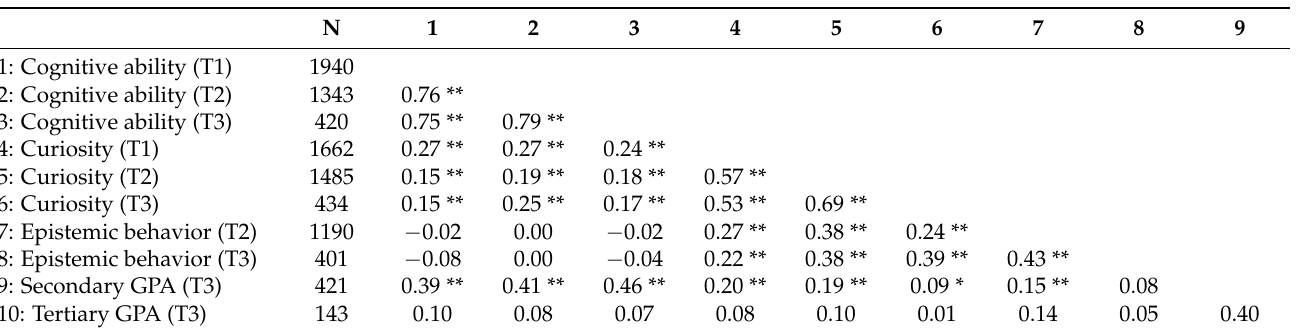
Table 1. Bivariate associations between the study